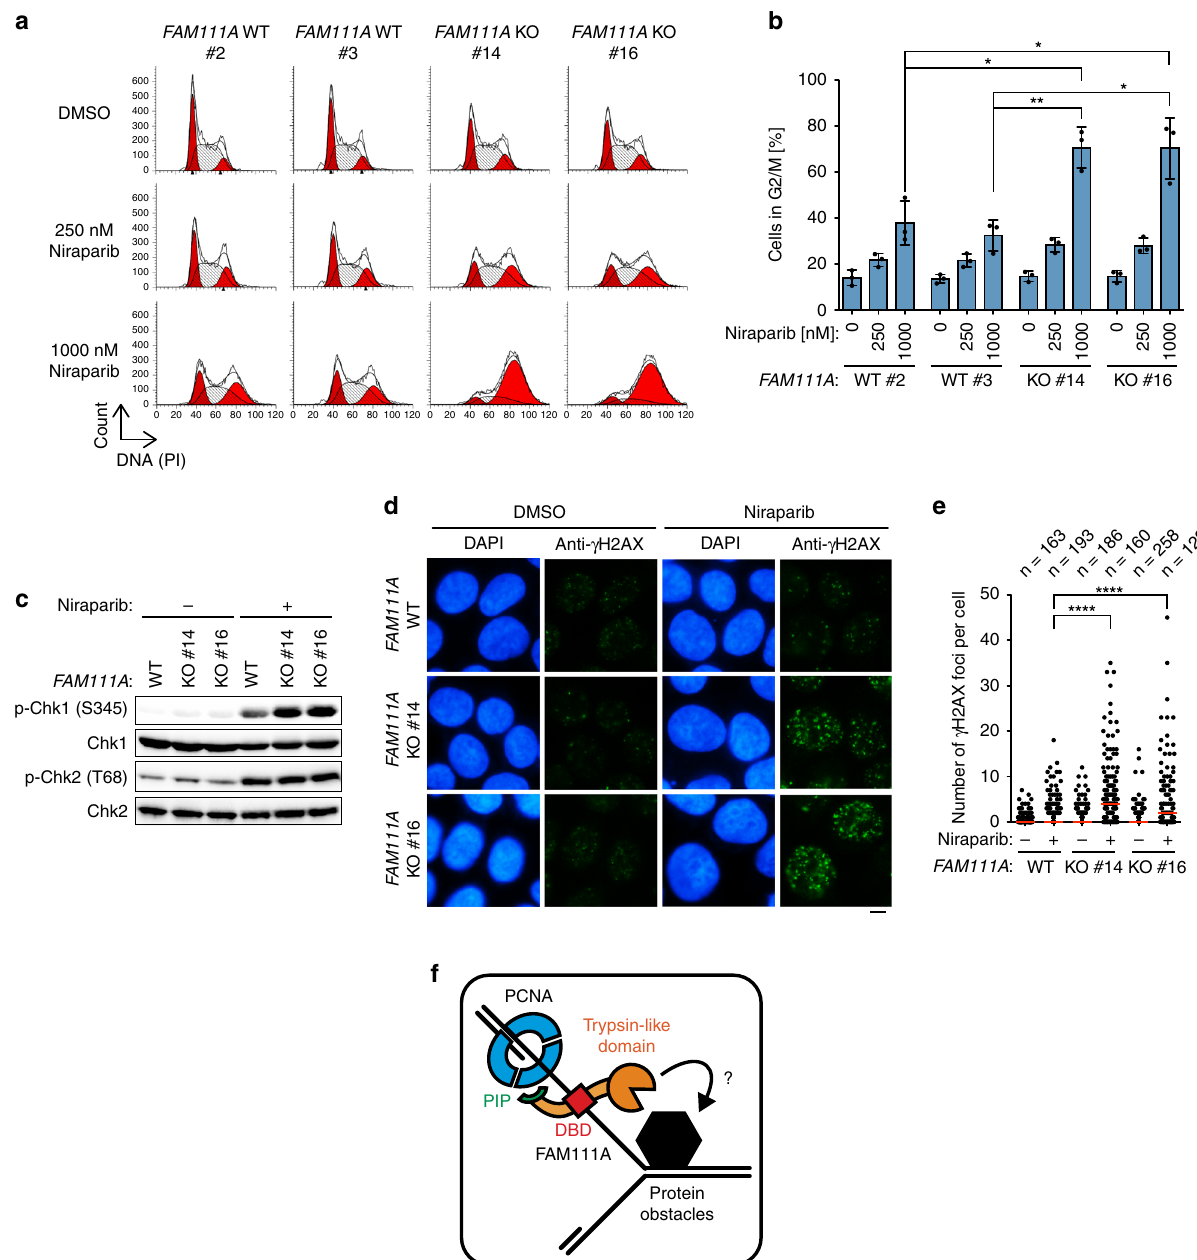
Fig. 6 FAM111A de fi ciency causes replication stress, DNA damage and cell-cycle arrest during PARPi treatment. a Cell-cycle pro fi ling. Diploid HAP1 clones (WT #2 and #3) and FAM111A KO HAP1 clones (#14 and #16) were treated with indicated concentration of niraparib or DMSO for 24 h and analyzed by fl ow cytometry. Representative histograms from three independent experiments are shown. b Quanti fi cation of cells in G2/M phase. Experiments were performed as in a . Percentages of cells in G2/M phase were quantitated using ModFit. Values are mean ± s.d. of independent experiments ( n = 3). * p < 0.05, ** p < 0.01 (two-tailed unpaired t -test). c Levels of p-Chk1 and p-Chk2 after niraparib treatment. Indicated HAP1 cells were treated with 1.5 µ M niraparib or DMSO for 24 h and indicated proteins were detected by Western blotting. d γ H2AX foci after niraparib treatment. Parental HAP1 (WT) or FAM111A KO clones (#14 and #16) were treated with 250 nM niraparib or DMSO for 24 h and stained with anti- γ H2AX antibody and DAPI. Scale bar, 5 µ m. e Quanti fi cation of γ H2AX foci per cell. Experiments were performed as in d . γ H2AX foci were counted and the distributions of number of foci per cell are plotted (red line: median). **** p < 0.0001 (two-tailed unpaired t -test). n is the number of individual measures. f Schematic representation of the working model depicting the role of FAM111A at replication forks encountering protein obstacles. PIP PCNA-interacting peptide box, DBD DNA- binding domain. Source data are provided as a Source Data fi and PARP1 , and eSpCas9(1.1) (kind gift from Feng Zhang, Addgene #71814) for 4h at 4°C and the beads were washed fi ve times with NP-40 lysis buffer. SPRTN . For CRISPR/Cas9 using the nickase Cas9 (pX335), the following pairs Precipitated proteins were analyzed by Western blotting. of gRNAs were used: FAM111A , set 1 (gRNA1 and gRNA2) and set 2 (gRNA3 and gRNA4); PARP1 , gRNA1, and gRNA2. The target sequences of gRNA are Generation of knockout cell lines . CRISPR/Cas9-based gene knockout was per- as follows: FAM111A gRNA1, 5 ′ -ATCAACCCACTAAGTGGCAC-3 ′ ; FAM111A gRNA2, 5 ′ -CATATTATTGGCCATCCATAA-3 ′ ; FAM111A gRNA3, 5 ′ -ATTATG formed using pX335 (kind gift from Feng Zhang, Addgene #42335) for FAM111A